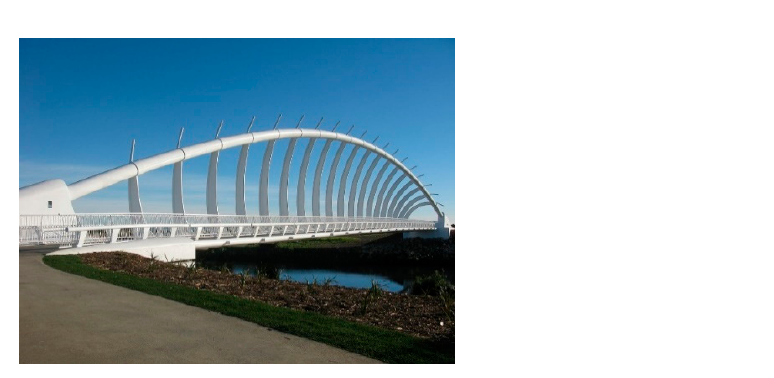
Figure 39. Stiff hangers fully fixed in the Te Rewa Rewa Bridge (New Zealand) (photo, Andrew Smith, Wikimedia Commons).